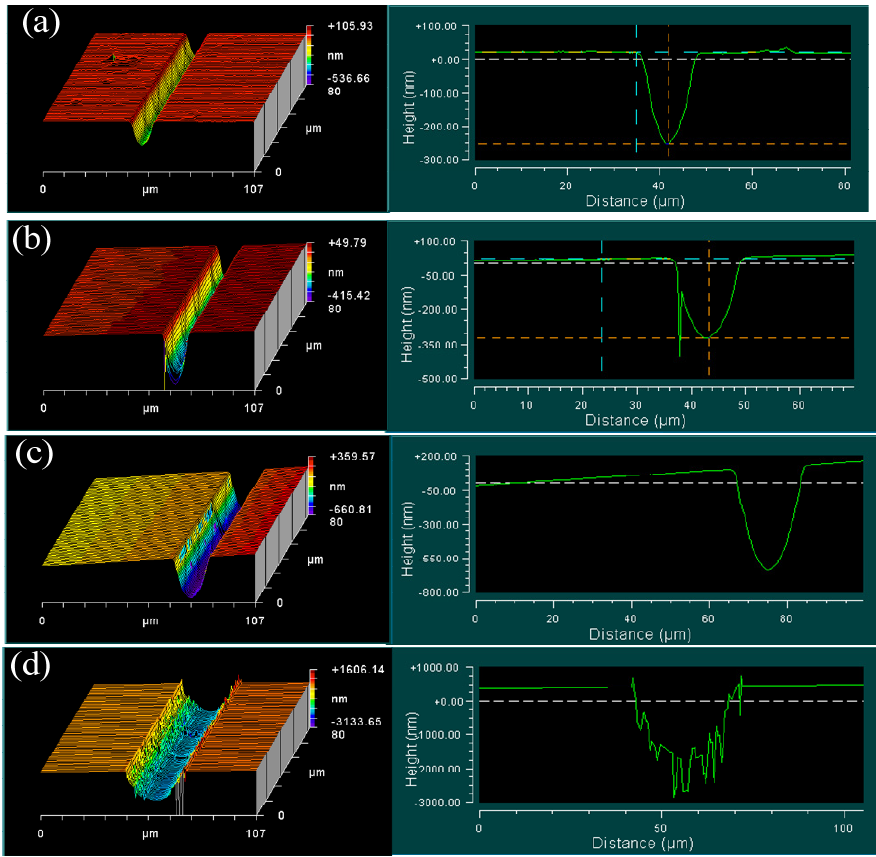
Figure 6. 3D surface morphologies and cross-sections of cutting groove at different undeformed chip thickness for BK7: ( a ) 272 nm; ( b ) 320 nm; ( c ) 800 nm; ( d ) 2100